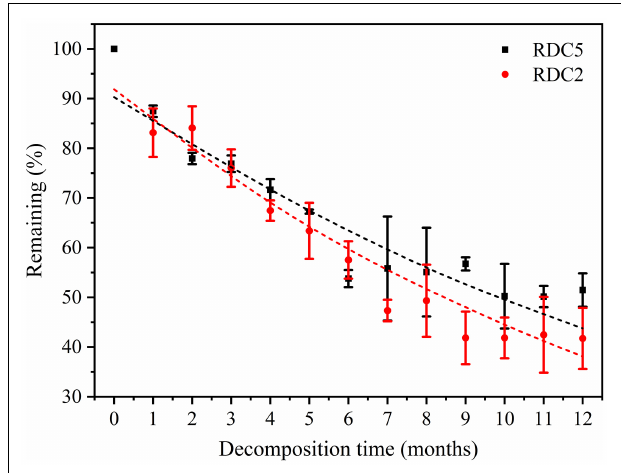
FIGURE 2 | Dry-matter mass loss during fine-root decomposition.